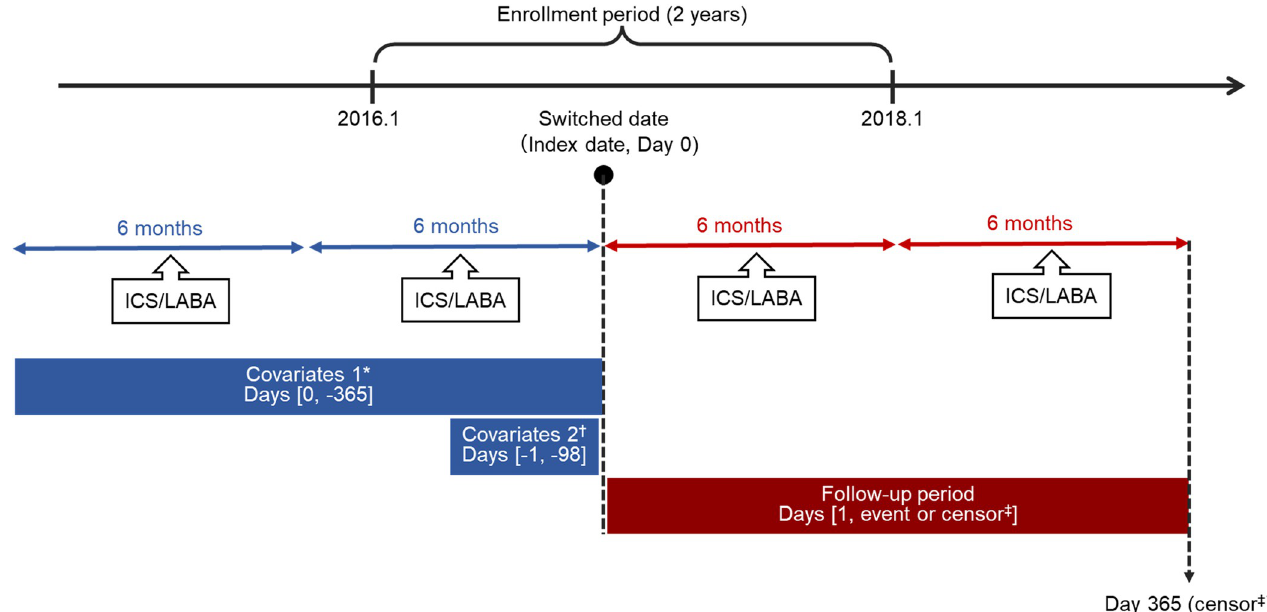
Fig 1. Study design. ICS, inhaled corticosteroid; LABA, long-acting β 2-agonist. � Medical history and complications, respiratory function-related tests, asthma treatment management fee, and history of asthma exacerbations. † Asthma treatments (ICS, leukotriene receptor antagonist, slow-release theophylline, disodium cromoglycate, long-acting muscarinic antagonist, LABA, oral corticosteroid, and biologic agents). ‡ Censoring by re-switching to another ICS/ LABA, adding an ICS, or switching to an ICS.